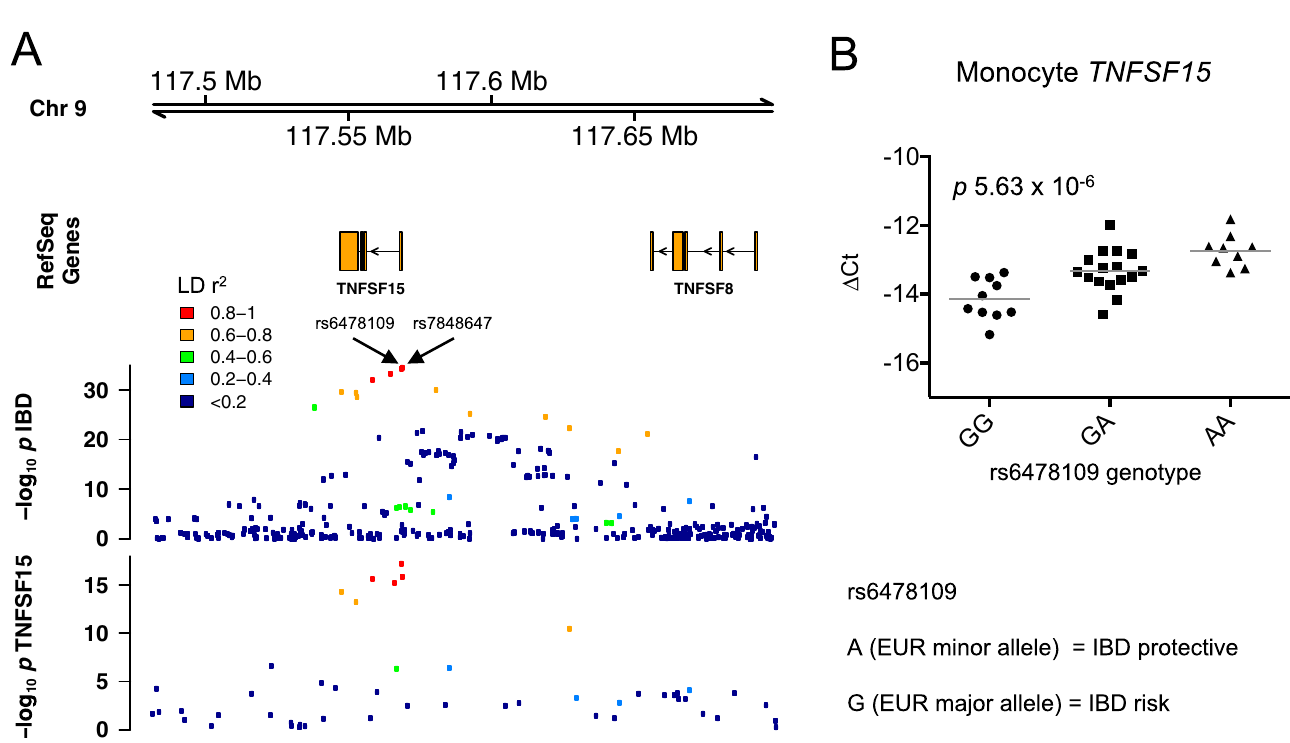
Fig 1. The IBD-protective rs6478109:A allele is associated with increased TNFSF15 expression. ( A ) Regional association plots for IBD (European ancestry cohort from Liu et al [4]) and TNFSF15 expression (n = 39 healthy individuals and 80 IBD patients). ( B ) TNFSF15 mRNA expression was measured in ex vivo monocytes relative to B2M by qPCR in a separate cohort of healthy individuals and plotted versus rs6478109 genotype (GG, n = 10; GA, n = 16; AA, n = 9). Expression is reported as Δ Ct, each point represents an individual, lines represent mean values, and p value is from linear regression.